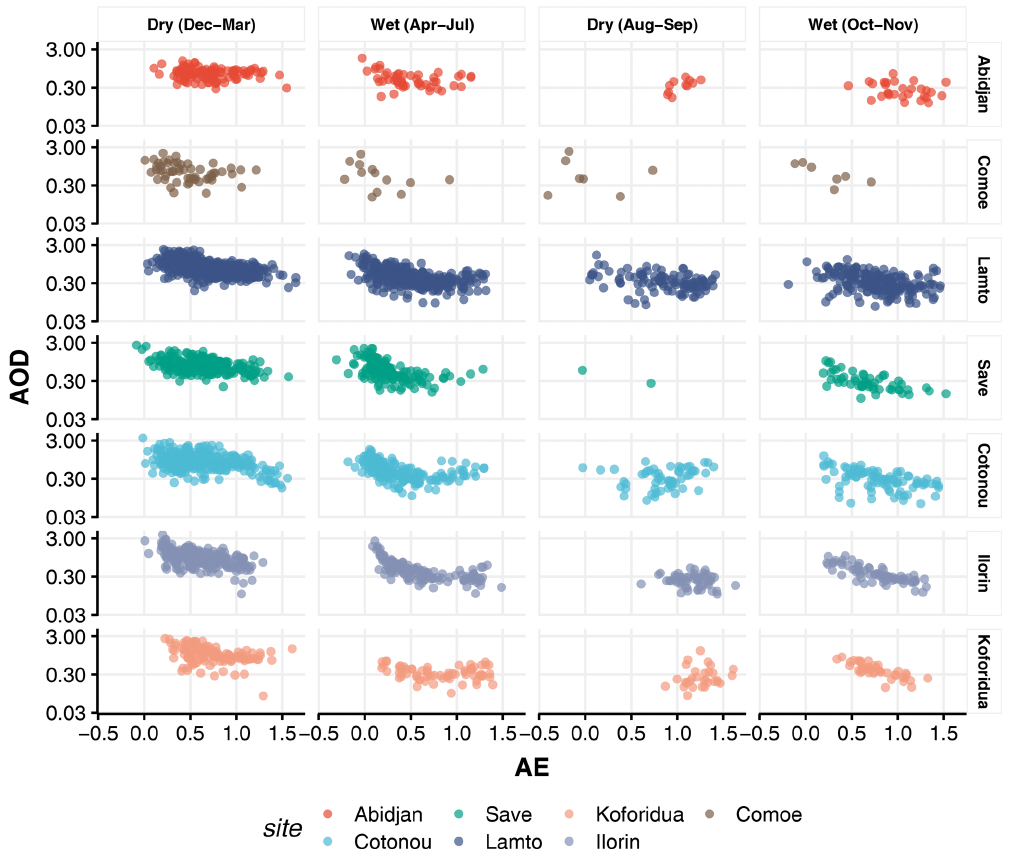
Figure 7. Scatterplots of sun photometer aerosol optical depth (AOD) vs. Ångström exponent (AE) split by sites and by seasons.